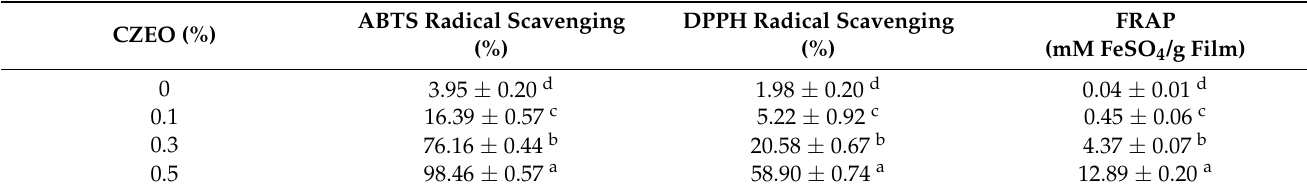
Table 3. Antioxidant activity of GBS films containing